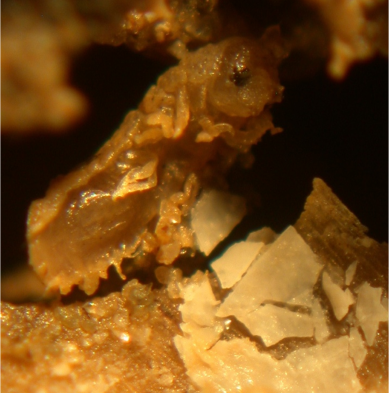
Figure 2. Limnoria sp. on immersed Scots pine sapwood at Marina di Scarlino.